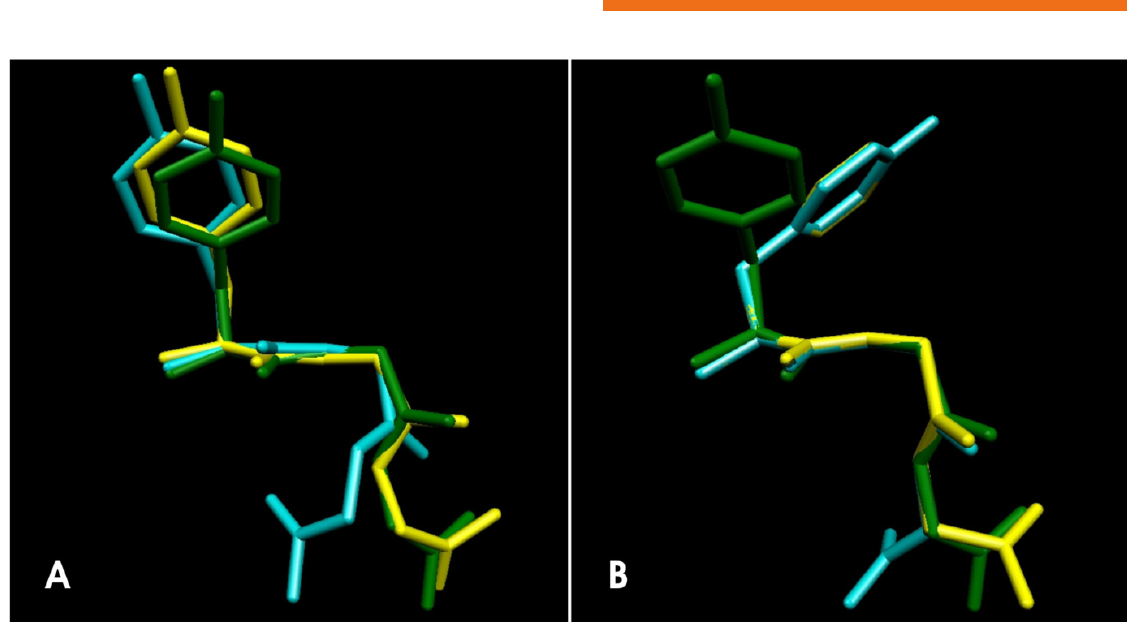
Figure 3. Overlapped geometries of the structure reported by Pichon-Pesme et al. [29] (in green) and; A) two YGG conformers obtained at RHF/6- 31G(d) level of theory (ygg09 conformation in light blue and geometry number 18 in yellow) B) two YGG conformers obtained at EDMC/ SRFOPT/ECCEP/3 level of theory. (Family 11 in light blue and family 12 in yellow). All hydrogen atoms are omitted for